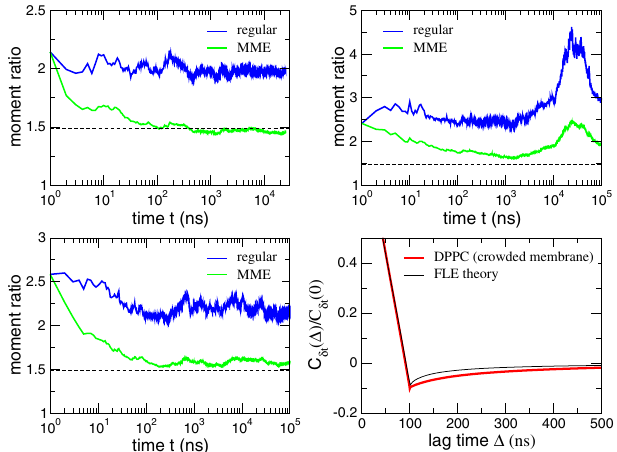
FIG. 6. Moment ratio of lipid molecules, h r 4 i = h r 2 i 2 (regular) and h r 4 i = h r 2 i 2 (mean maximal excursion). (Top left) MME MME DPPCs in the protein-poor membrane, (top right) DPPCs in the protein-rich membrane, (bottom left) DLPCs in the protein- t Þ refers to the rich membrane. Here, the MME distance r MME ð maximum distance reached from the origin until time t [102]. For two-dimensional FLE motion with 0 < α < 1 , the moment ratio is 2 for regular and < 1 . 49 (dashed line) for MME. (Bottom right) Velocity autocorrelation function C ð Δ Þ ¼ h v δ t ð t þ Δ Þ · v δ t ð t Þi for the average velocity v δ t ð t Þ ¼ ½ r ð t þ δ t Þ − r ð t Þ(cid:2) = δ t with the chosen time interval δ t ¼ 100 ð ns Þ . The result for DPPCs in the protein-rich membrane is compared to the corresponding theo- retical curve of FLE